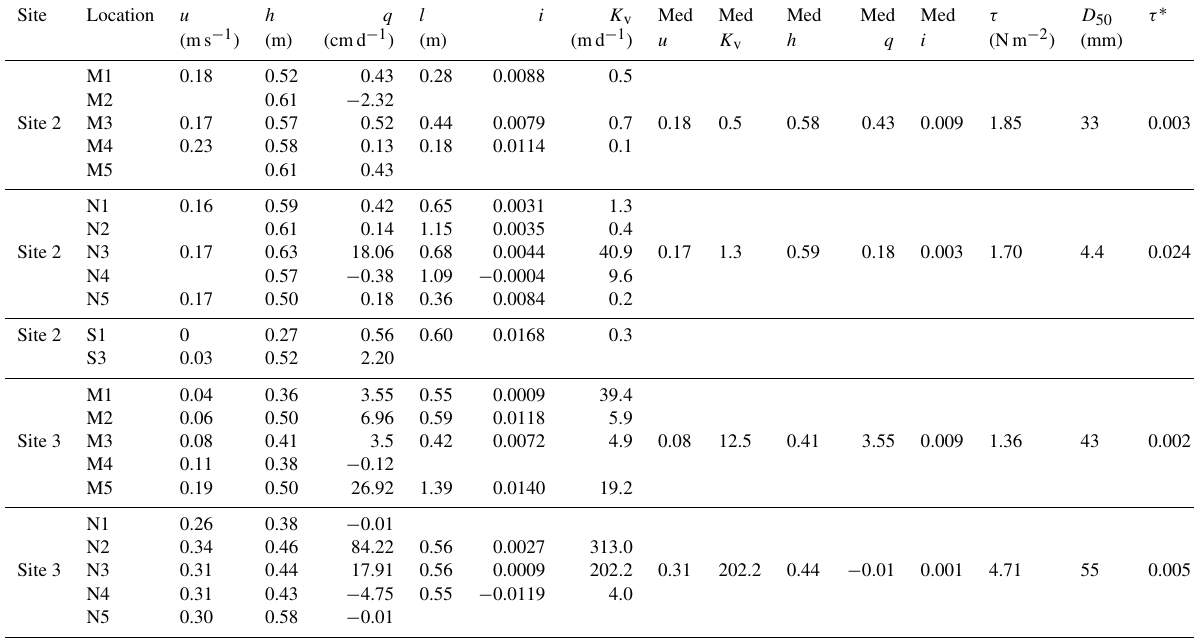
Table 1. Median values for parameters measured at each installation location at sites 2 and 3. Site Location